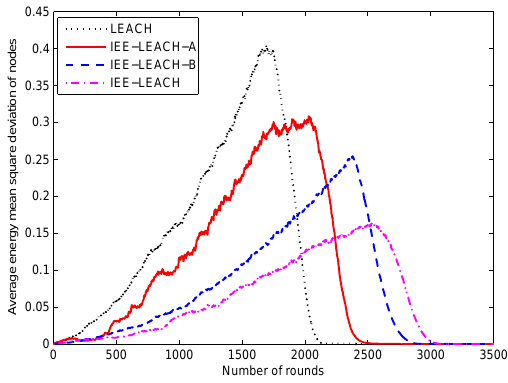
Figure 9. Comparison of average energy mean square deviation of nodes every 10